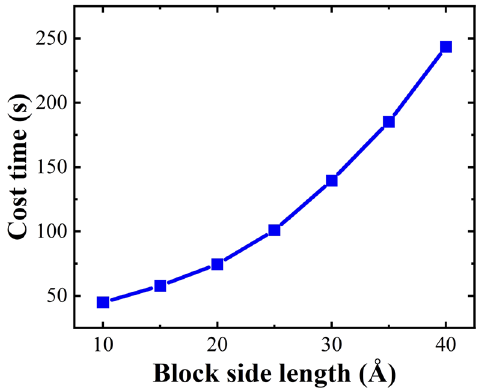
Figure 6: Cost time of cage recognition by HTR as a function of water molecules in sI - type clathrate hydrate